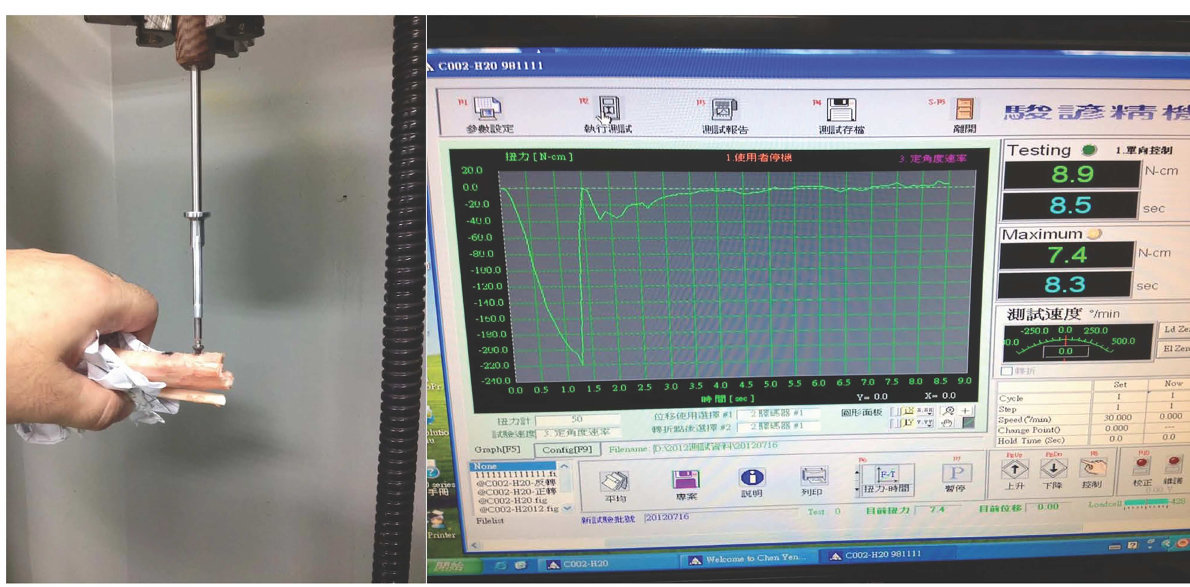
Fig 1. Digital torque gauge used to determine RTV of cortical